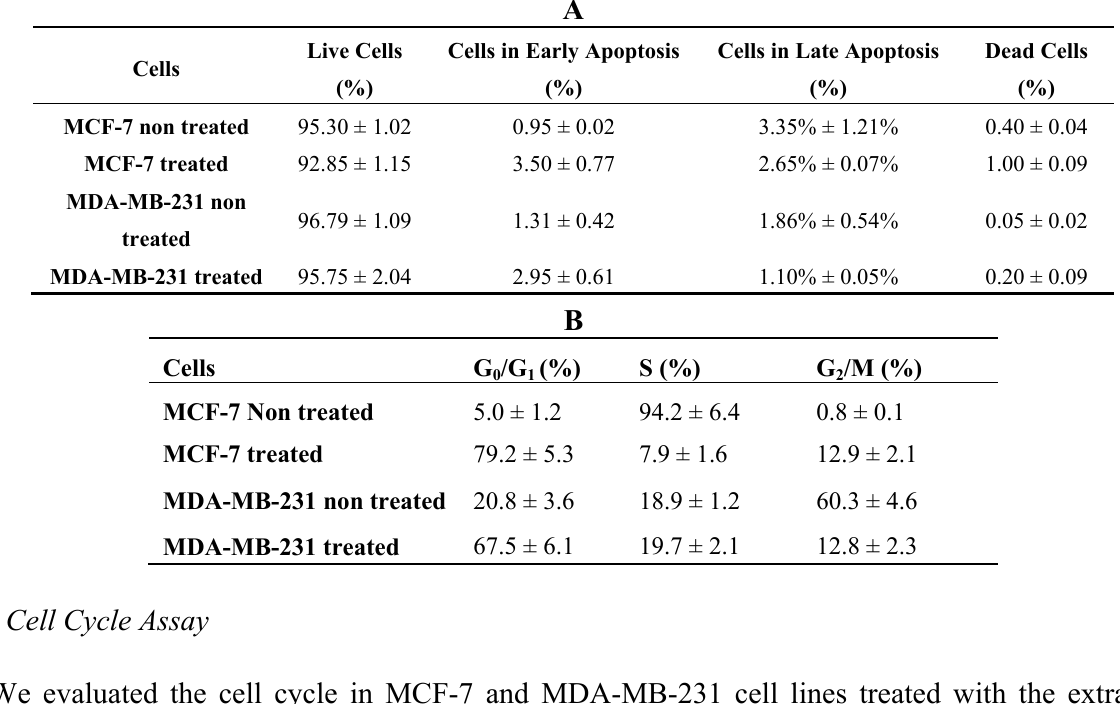
Table 2. Rate of apoptosis ( A ) and cell percentages in G evaluated in two breast cell lines, MDA-MB-231 and MCF-7, non treated and treated for 24 h with 0.5 μ L and 0.6 μ L of hydrophilic extracts from PSO, respectively. Mean of triplicate assays are